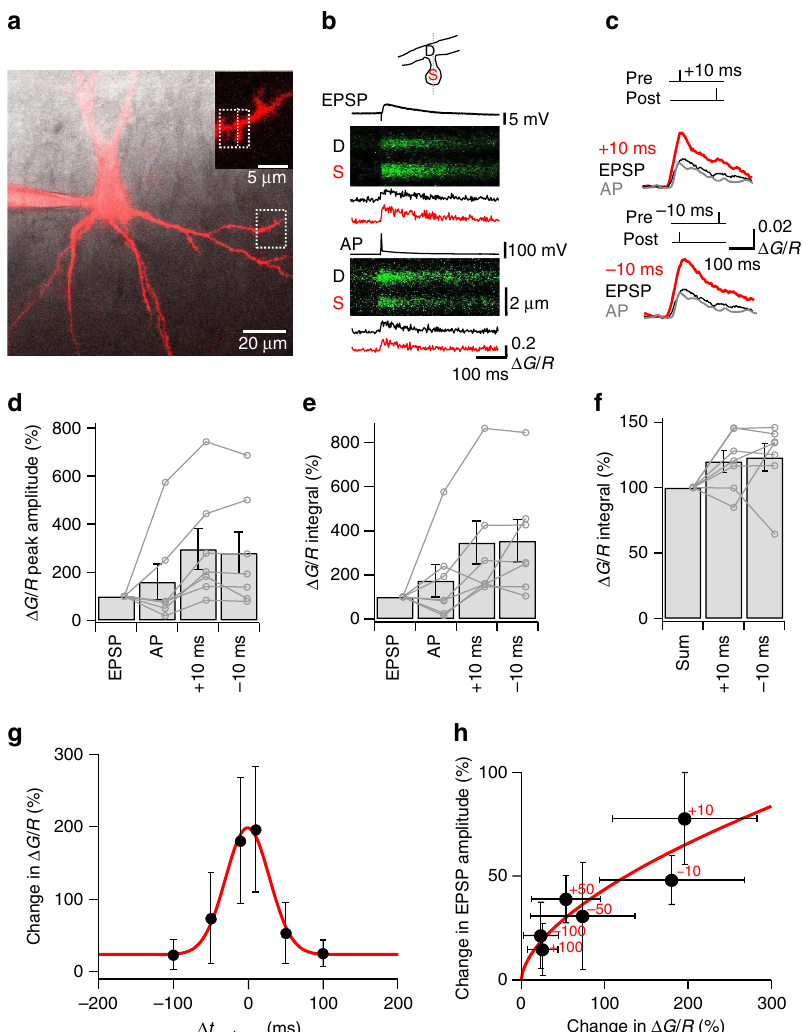
Figure 2 | Summation of EPSP- and AP-induced [Ca 2 þ ] transients in spines of CA3 pyramidal neurons. ( a ) Fluorescence image of a CA3 pyramidal neuron loaded with Fluo-5F and Alexa Fluor 594 (maximum projection of stack of 48 1- m m confocal sections; excitation wavelength 594nm), superimposed with the corresponding infrared-DIC image. The region indicated by the box is shown on an expanded scale in inset. ( b ) Spine [Ca 2 þ ] transients evoked by synaptic stimulation and backpropagated APs. Top, schematic illustration of the line scan configuration (dotted line, 400Hz). Centre, [Ca 2 þ ] transient during a synaptically evoked EPSP. Bottom, [Ca 2 þ ] transient during a backpropagated AP. In each panel, upper graph represents membrane potential trace, middle shows G fluorescence signal against distance (vertical axis) and time (horizontal axis), and bottom indicates D G / R versus time in the dendrite (black) and the spine (red). ( c ) [Ca 2 þ ] transients during EPSPs (black traces), APs (grey traces), pre–postsynaptic pairing ( D t ¼ þ 10ms; red trace, top), and post–presynaptic pairing ( D t ¼ (cid:2) 10ms; red trace, bottom). Note that pairing markedly increased the peak amplitude of the [Ca 2 þ ] transient in comparison to isolated EPSPs. ( d , e ) Summary of the amplitude ( d ) and integral ( e ) of [Ca 2 þ ] transients evoked by single EPSPs, single APs, pre–postsynaptic pairing ( D t ¼ þ 10ms) and post–presynaptic pairing ( D t ¼ (cid:2) 10ms). Data were normalized to the EPSP value. Circles represent data from individual cells, bars indicate mean ± s.e.m. Data from the same cell were connected by lines. ( f ) Supralinearity of summation. Summary bar graph shows integral values, normalized to the arithmetic sum of EPSP and AP values. Data in d – f from 7 cells. ( g ) A broad and symmetric [Ca 2 þ ] transient summation curve in CA3 pyramidal neuron spines. Peak amplitude of [Ca 2 þ ] transients during combined pre–postsynaptic or post– presynaptic stimulation, normalized to that of isolated EPSPs, was plotted against pairing time interval D t (7 cells total). Red curve, Gaussian function with offset fit to the data points (best-fit value for offset, 23.7%). Note that the [Ca 2 þ ] transient amplitude versus pairing interval curve was broad and symmetric, similar to the STDP curve. ( h ) Plot of change in EPSP amplitude against change of [Ca 2 þ ] transients during different pairing sequences. Numbers near symbols represent the values of D t between AP and EPSP (red, in ms). EPSP potentiation data were taken from Fig. 1. Red curve, power function fit to the data points (power coefficient at the soma 25.9 ± 1.0 ms in the dendrite (26 dendritic-somatic recordings; Fig. 3d). In contrast, the AP peak amplitude declined as a function of distance and showed a faster time course (Fig. 3b) 21 . Thus, at distal locations, the ADP became an increasingly important component of the backpropagated signal.